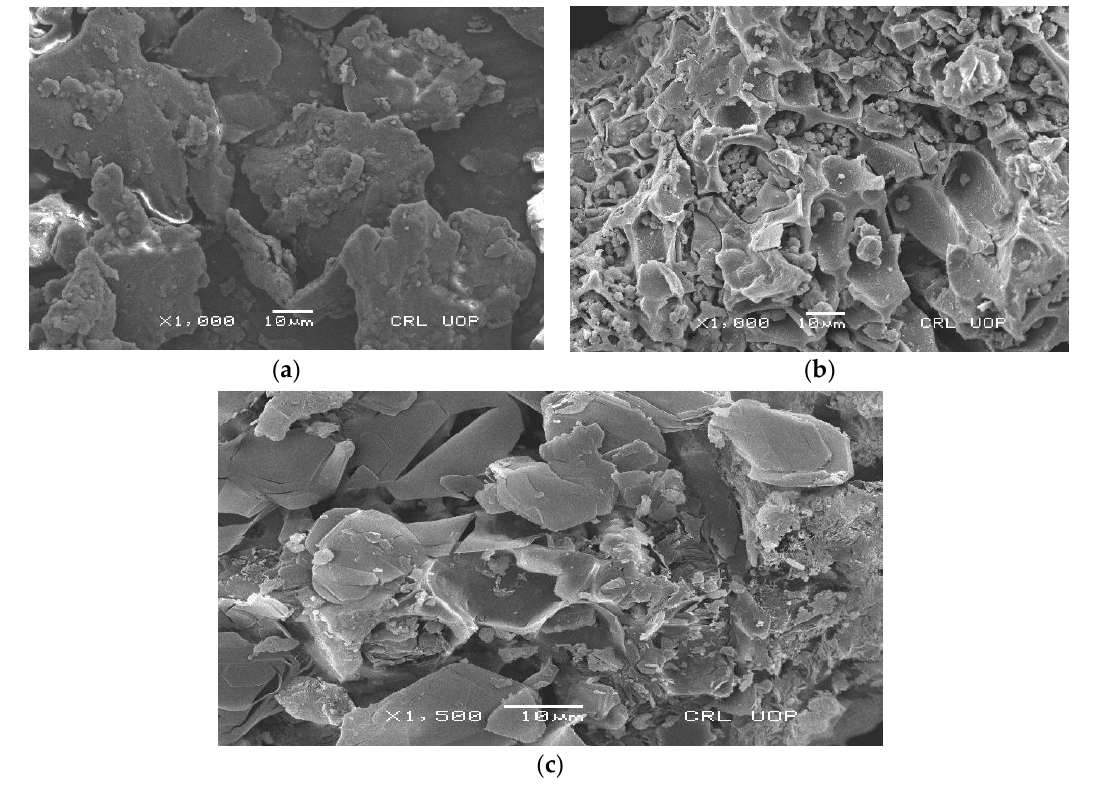
Figure 2. SEM images of ( a ) biomass, ( b ) acid-treated AC and ( c ) base-treated AC.